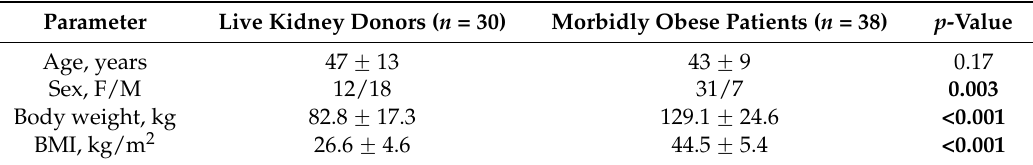
Table 1. Baseline characteristics of the study